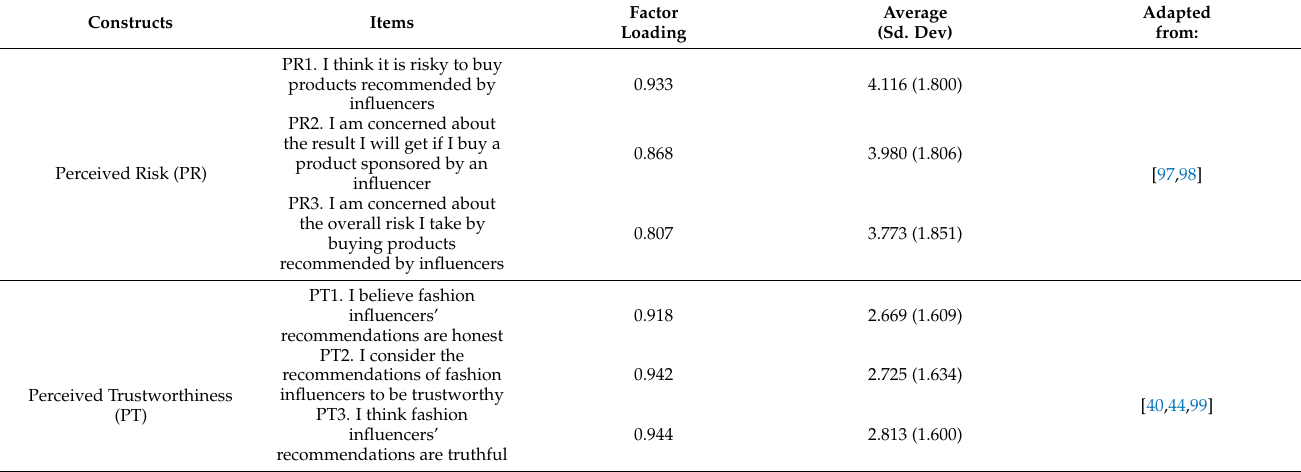
Table 2. Measurement model and factor